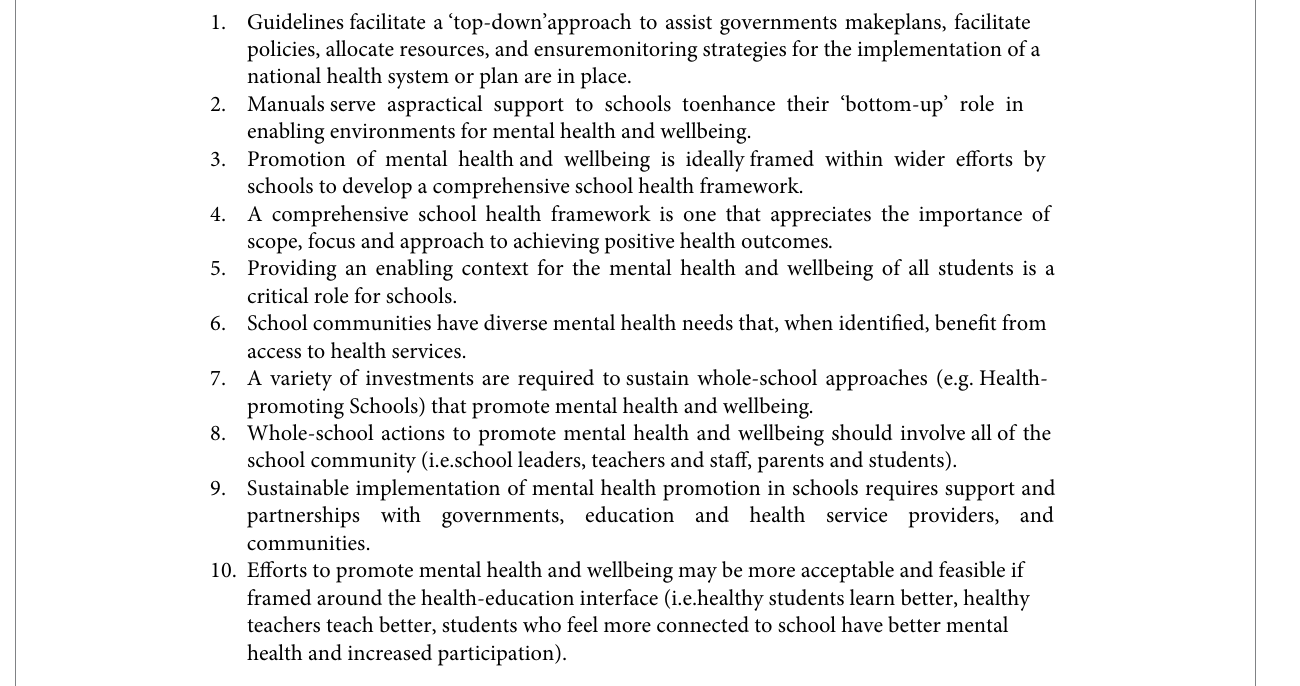
FIGURE 4 Key recommendations synthesized from the 16 UN agencies’ guidelines and